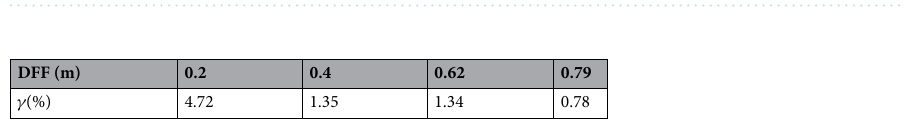
Figure 16. Displacement time history comparison (SRR is 4, DFF is 0.2 m).